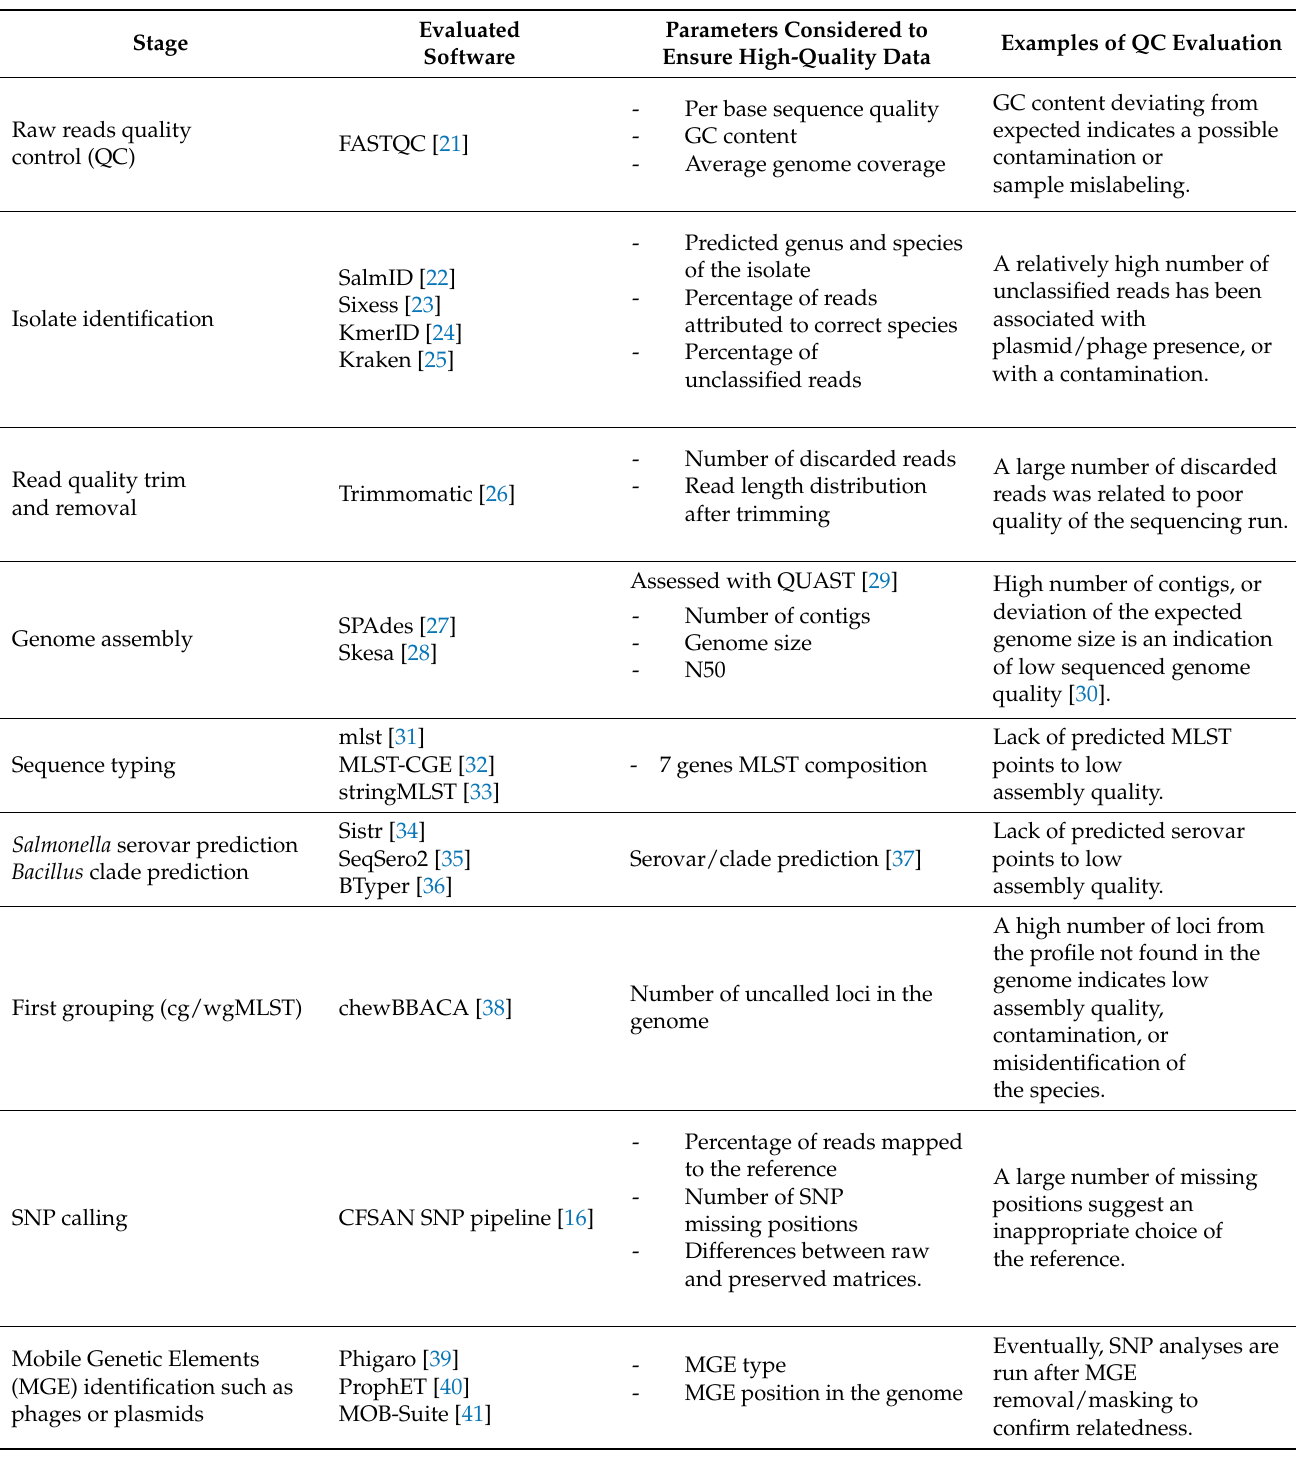
Table 1. List of main stages, benchmarked software and parameters considered to ensure high-quality